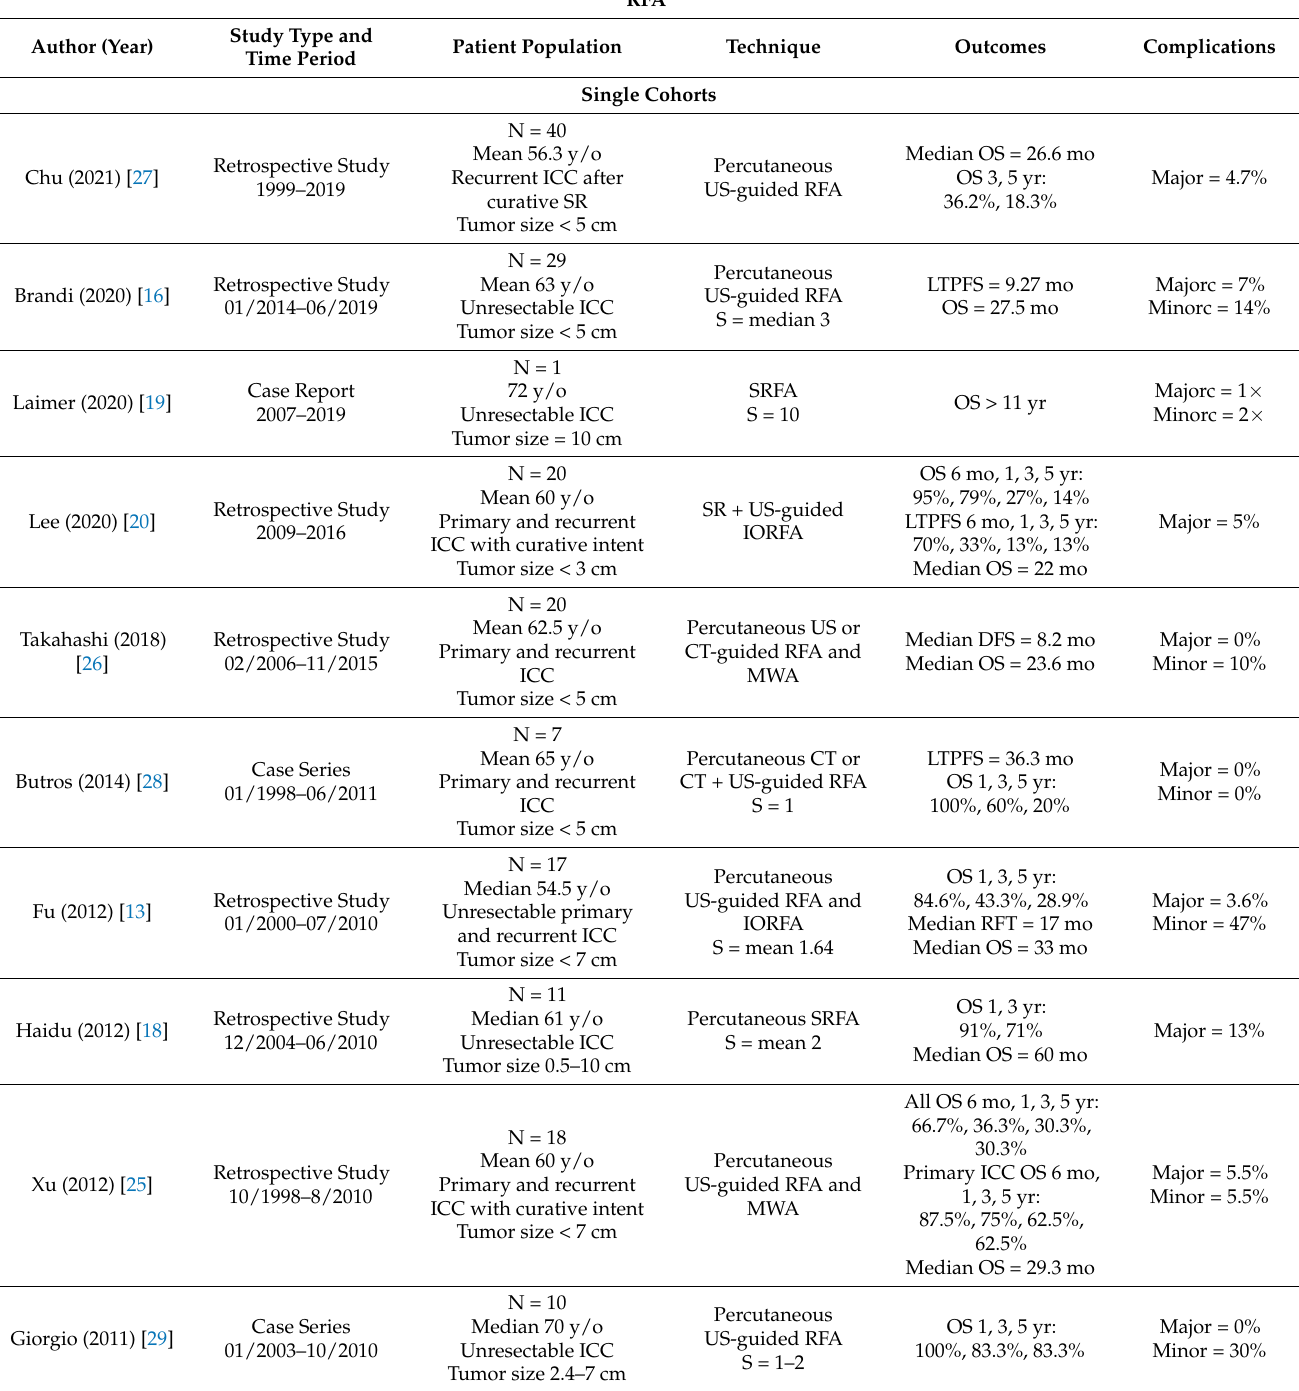
Table 1. Studies examining radiofrequency ablation (RFA) for intrahepatic cholangiocarcinoma.